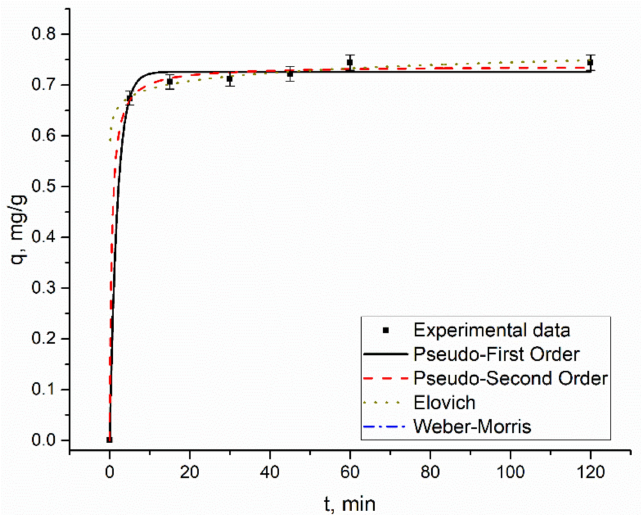
Figure 4. Kinetics of rhenium biosorption on yeast biomass.